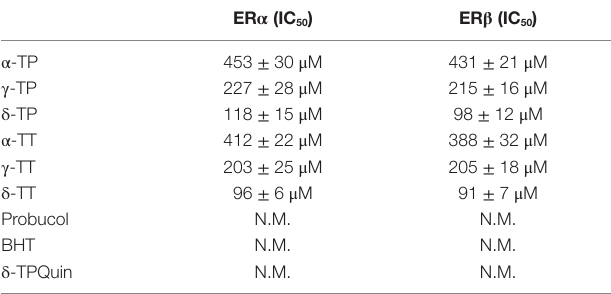
TaBle 1 | er binding